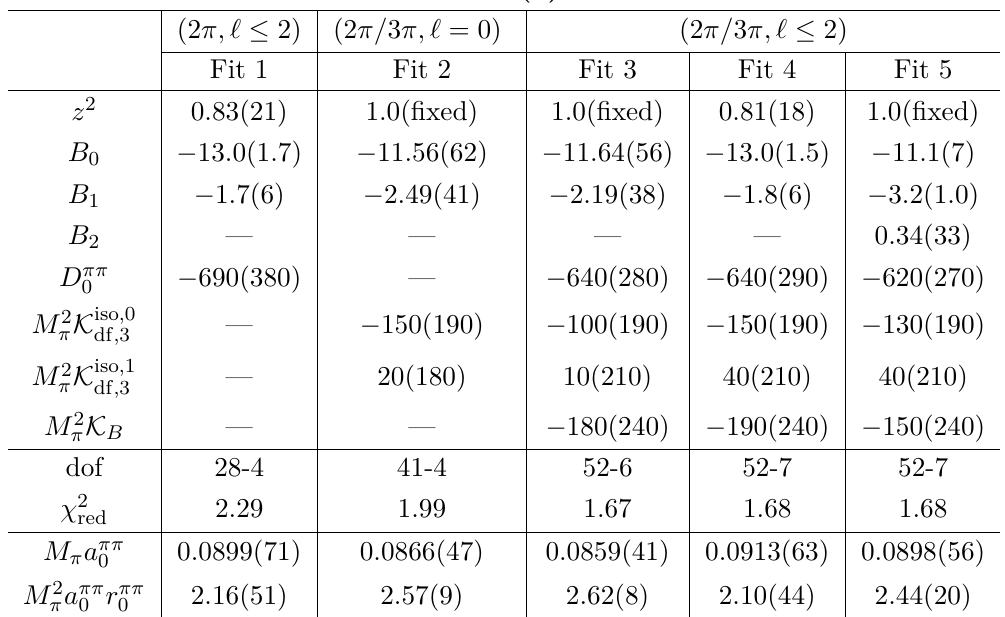
= 3 . 74 M π 2 , max = 4 . 74 M π ; we have discarded some max